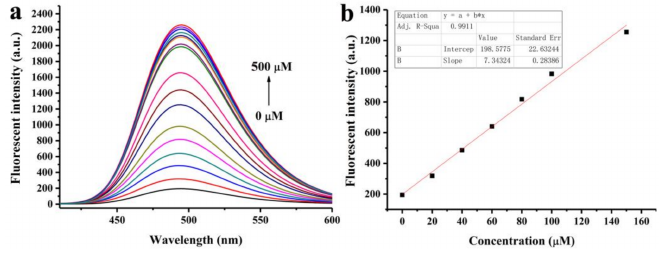
Figure 3. ( a ) Fluorescence titration of BPO-Py-Cl (10 µ M) with SO 3 2 − (0, 20, 40, 60, 80, 100, 150, 200, 250, 300, 350, 400, 450, 500 µ M) ( λ ex = 390 nm, slit: 2.5 nm/5 nm) in a 10 mM PBS:DMSO = 8:2 pH 6.0 buffer solution; and ( b ) linear fit of fluorescence intensity changes with Na 2 SO 3 . λ ex = 390 nm. Slit: 2.5 nm/5 nm.